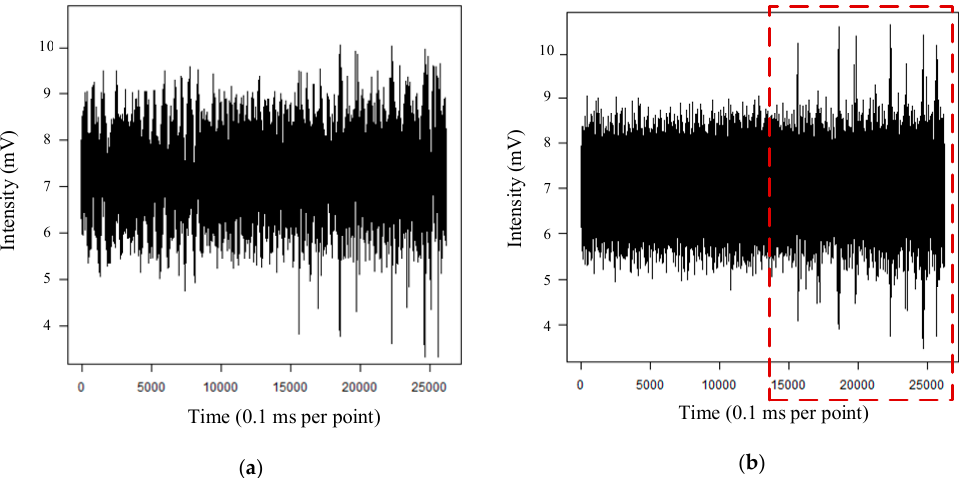
Figure 4. Comparison of the standard signal enhancement based on CEEMDAN-KL: ( a ) Original signal and ( b ) Signal after the enhancement.